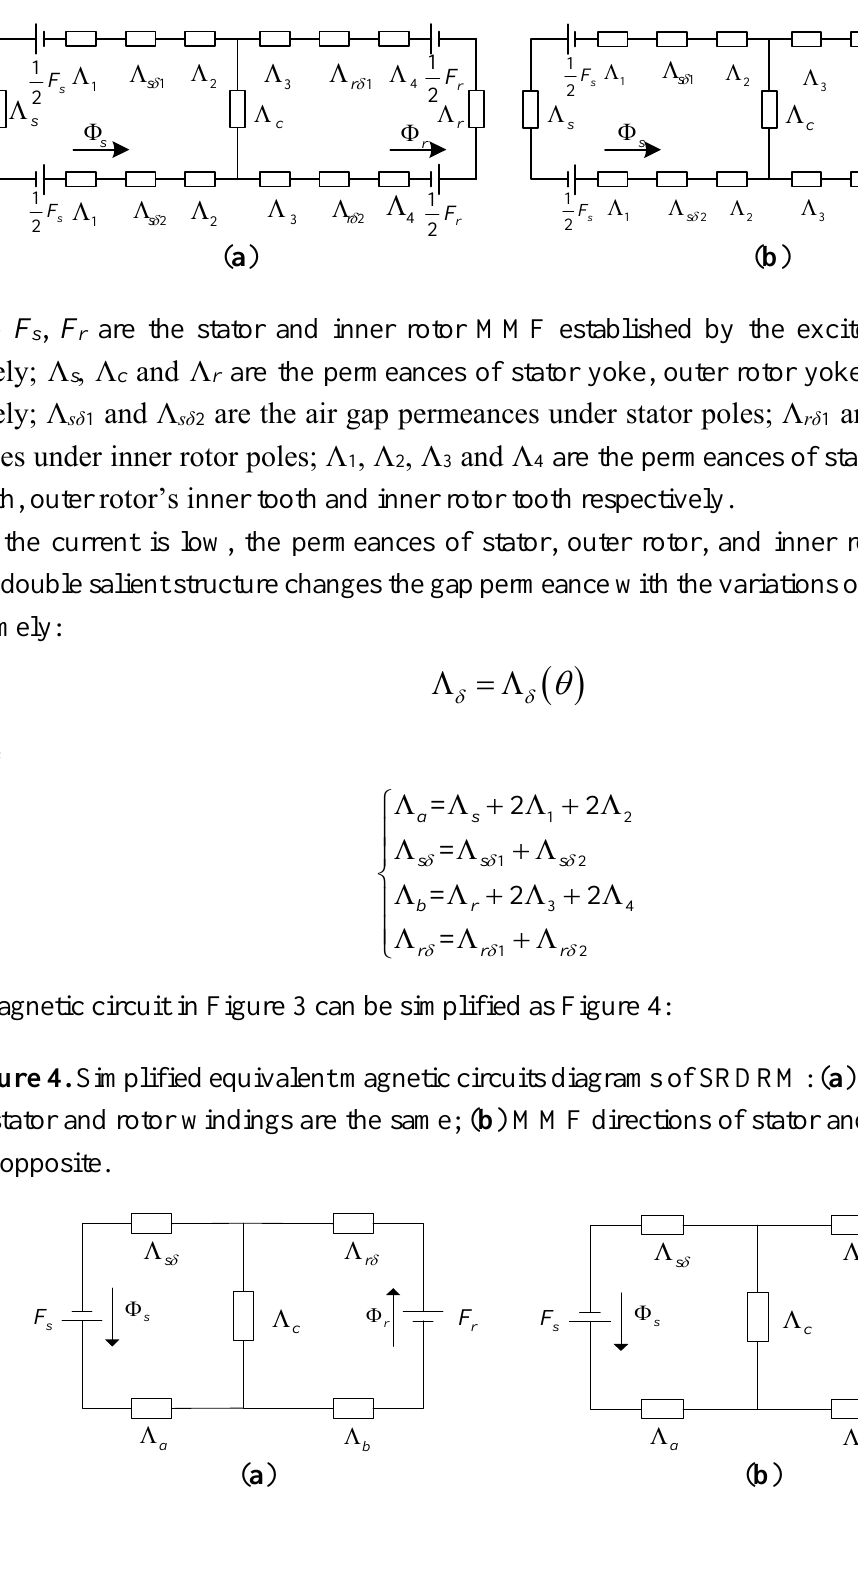
Figure 3. Equivalent magnetic circuits of SRDRM: ( a ) MMF directions of stator and rotor windings are the same; ( b ) MMF directions of stator and rotor windings are opposite.